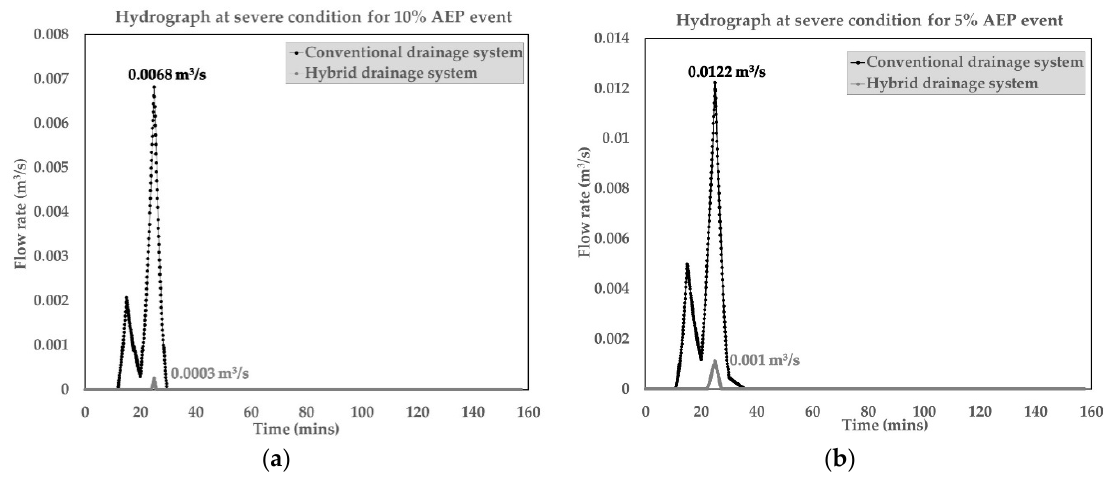
Figure 5. Comparison of overflow routes for ( a ) 10% and ( b ) 5% AEP storm events.